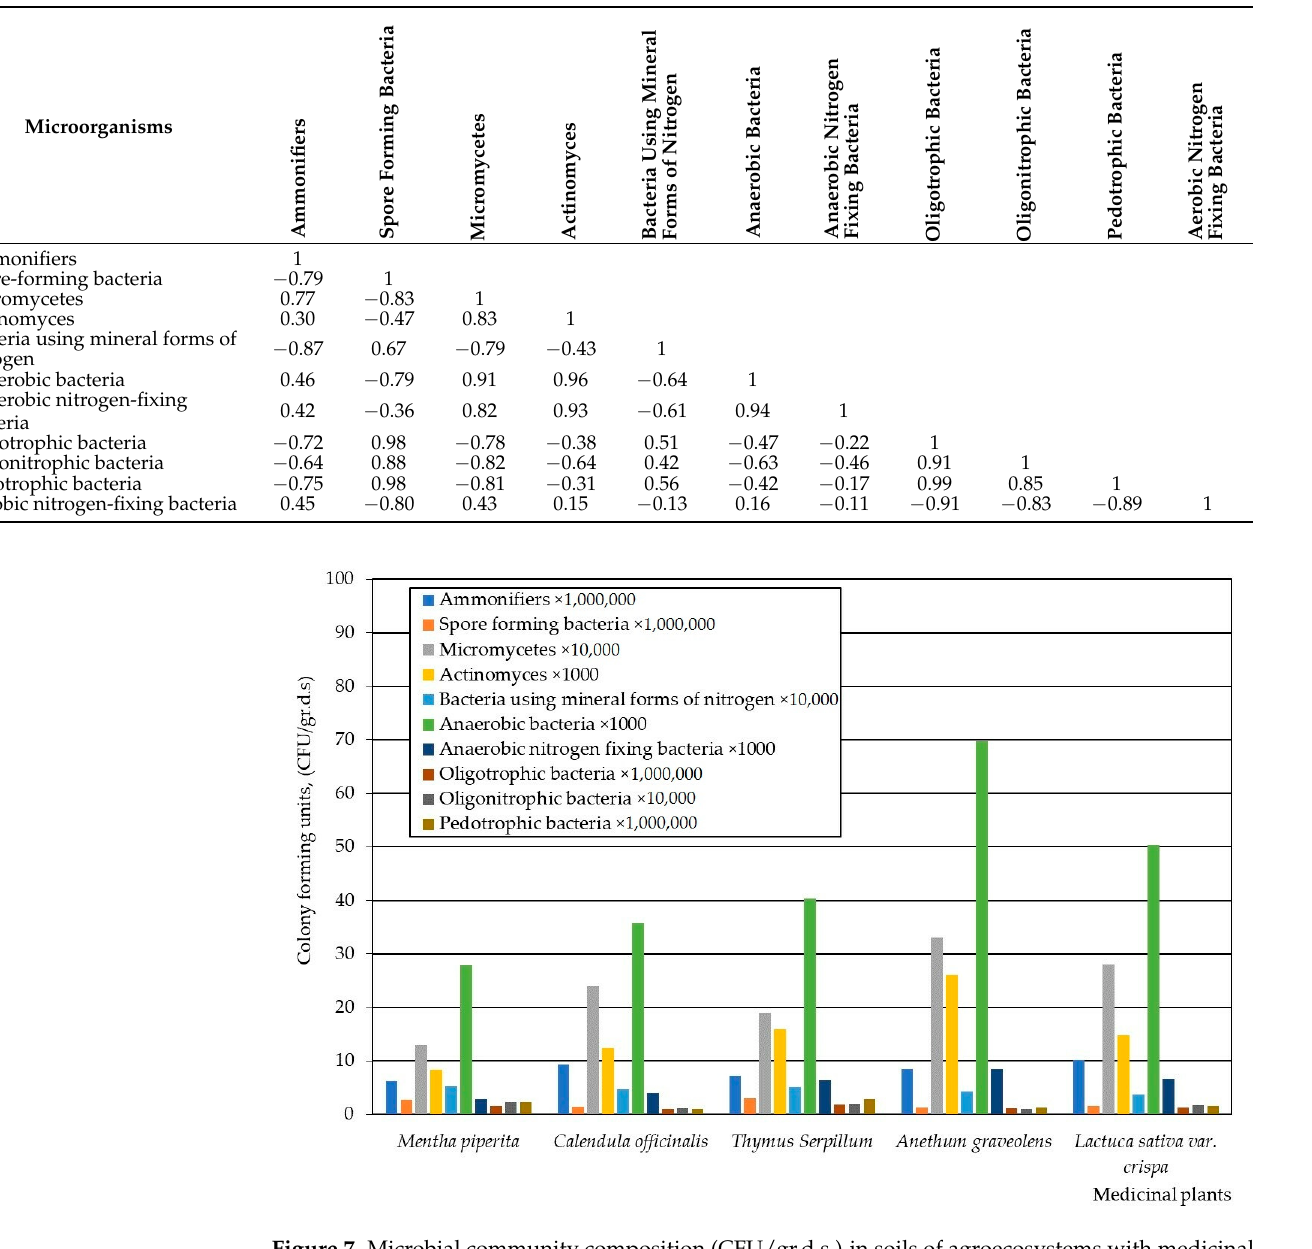
Table 3. The integrity of the soil microbial community in edaphotopes of agroecosystem of medicinal plants without antibiotic contamination.